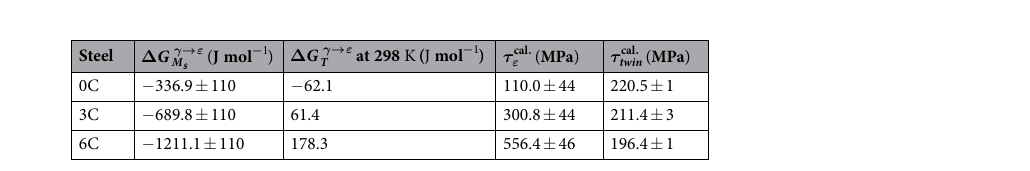
Table 1. Physical properties employed for SFE calculation of three utilized steels. * The lattice parameters of ε martensite in 0C steel were calculated using empirical equations for parameters of ε martensite in binary Fe-Mn steels 41 . ** The lattice parameters of ε martensite in 3C and 6C steels were taken from parameters of ε martensite in Fe-15Mn-0.37C (wt.%) steel 36 .